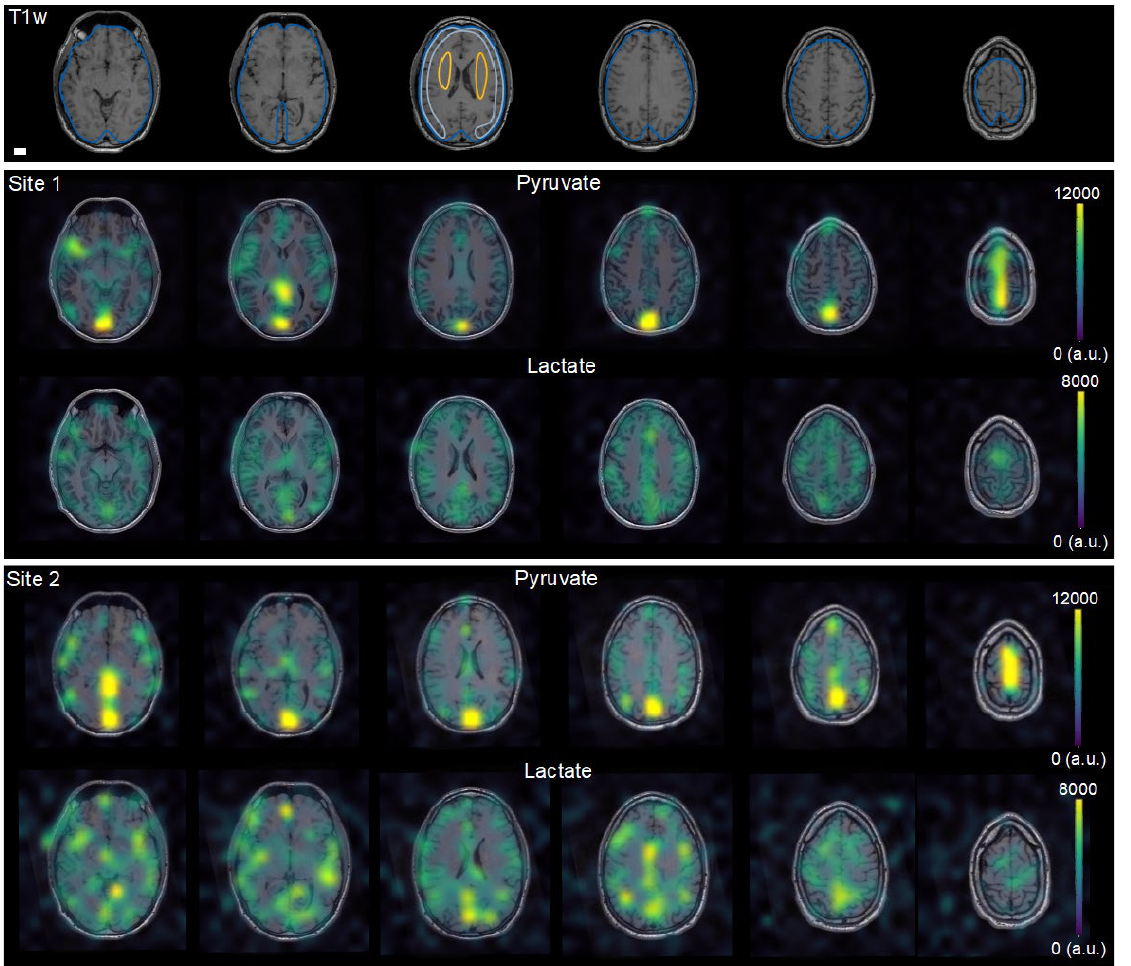
Figure 2. Comparison of hyperpolarized [1- 13 C]pyruvate MRI data from each site in the same participant. After injection of hyperpolarized [1- 13 C]pyruvate, dynamic images of [1- 13 C]pyruvate and [1- 13 C]lactate and were acquired in the same subjects at two sites. The six most cranial summed images are shown overlaid on T1 weighted (T1w) images from site 2, highlighting comparability between sites. Example regions of interest are shown for the whole brain (blue), deep white matter (yellow), and cortex (grey). The white scale equals 2 cm.